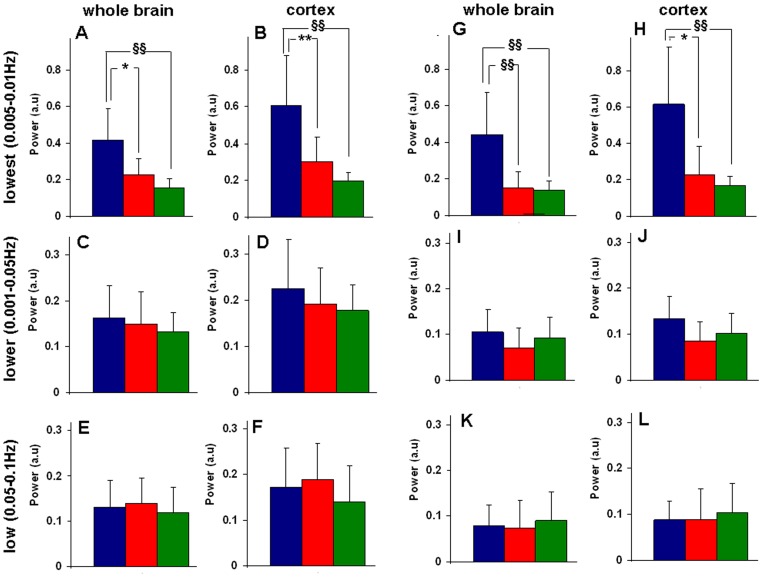
mCU modulation impacted spectral power of the low frequency (<0.1 Hz) R-fMRI BOLD fluctuations in the whole brain and cortex during A–F.Ru360 and G–L. Kaempferol treatment. R-fMRI spectral power were analyzed in three different frequency bands namely lowest (0.005–0.01 Hz), lower (0.01–0.05 Hz) and low (0.05–0.1 Hz) respectively. Inhibition of mCU activity with Ru360 (dose-1 = 120 µg/kg; dose-2 = 240 µg/kg) reduced the spectral power in the lowest band for A. the whole brain and B. cortex. No significant effect was observed in the C, D. lower band and E, F. low band over 7 animals from the Ru360 treated group. Enhancement of mCU activity with Kaempferol (dose-1 = 1 mg/kg; dose-2 = 2 mg/kg) reduced the spectral power in the G, H. lowest band. No significant effect was observed in the I, J. lower and K, L. low band over 7 animals from the Kaempferol group. Significantly different compared to control §§P<0.001, *P<0.005, **P<0.02; Kolmogorov-Smirnov test. Blue:control; red:dose-1; green:dose-2. Error bars represent the group standard deviation.